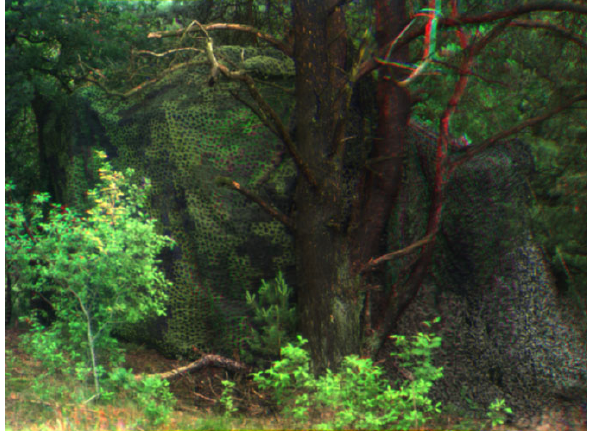
Figure 3. Concealed vehicle.